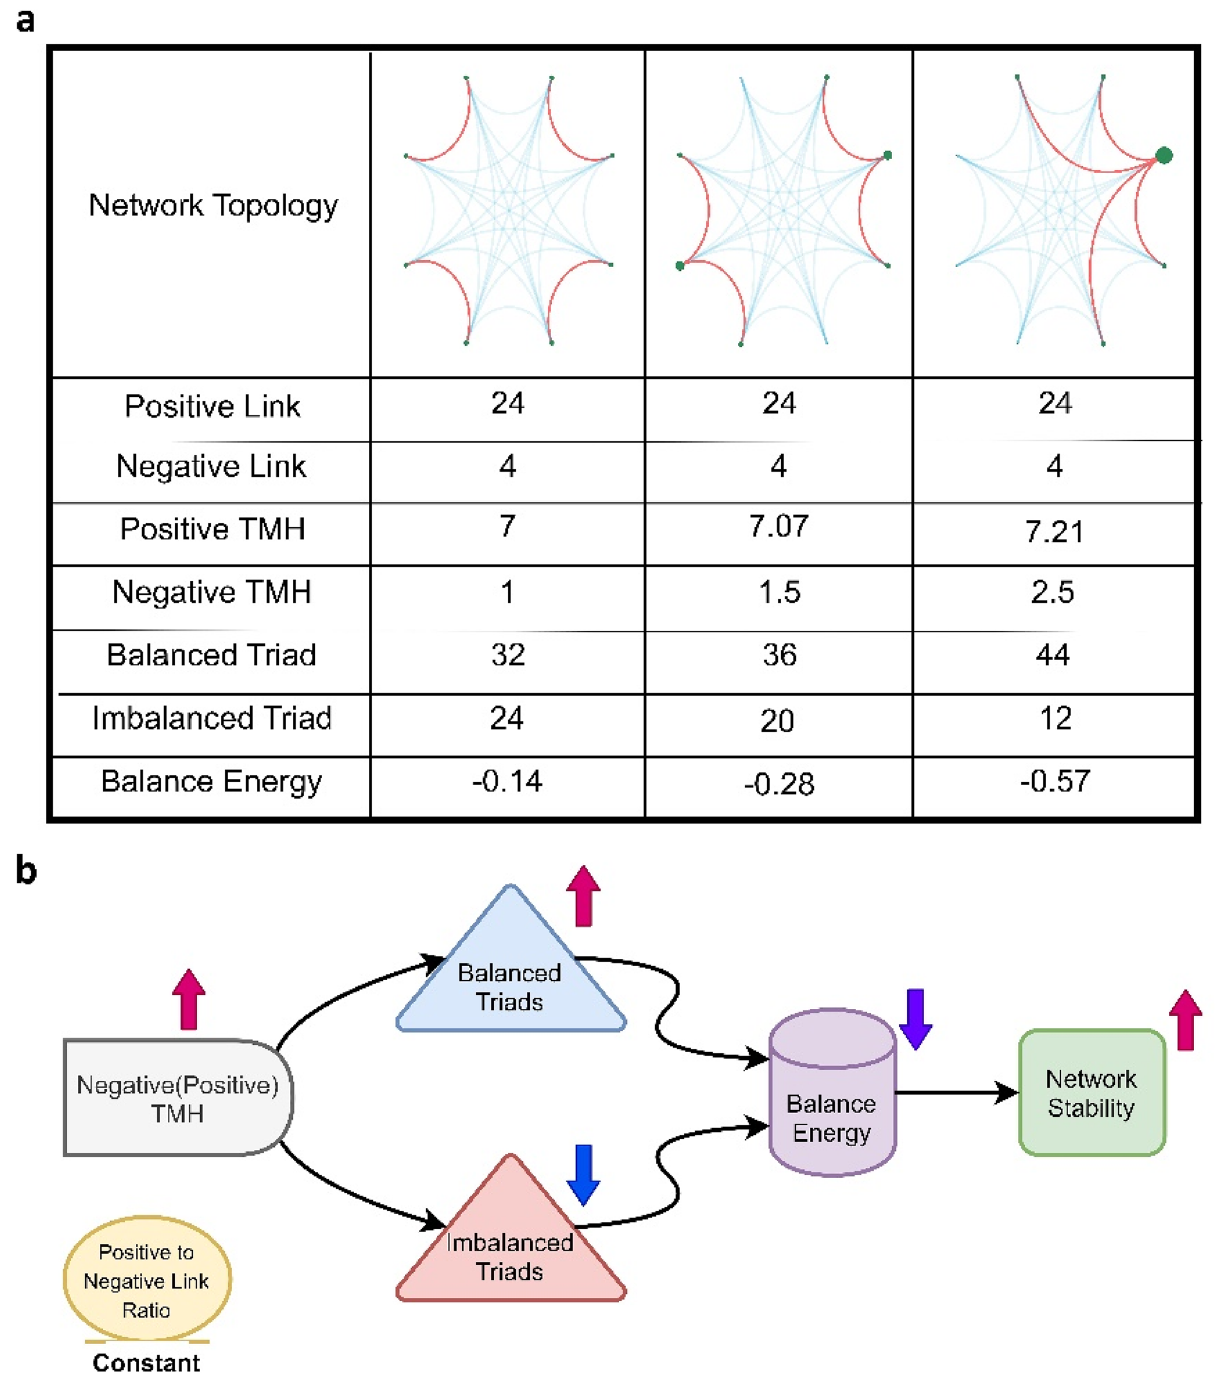
Figure 5. Effect of changing signed topology on the stability of the signed network. (a) Descriptive table. Rows demonstrate corresponding metrics of each topology. Positive and negative links of networks are indicated with blue and red curved lines, respectively. The size of green circles displays negative degrees of nodes. (b) Schematic diagram. TMH tendency to make